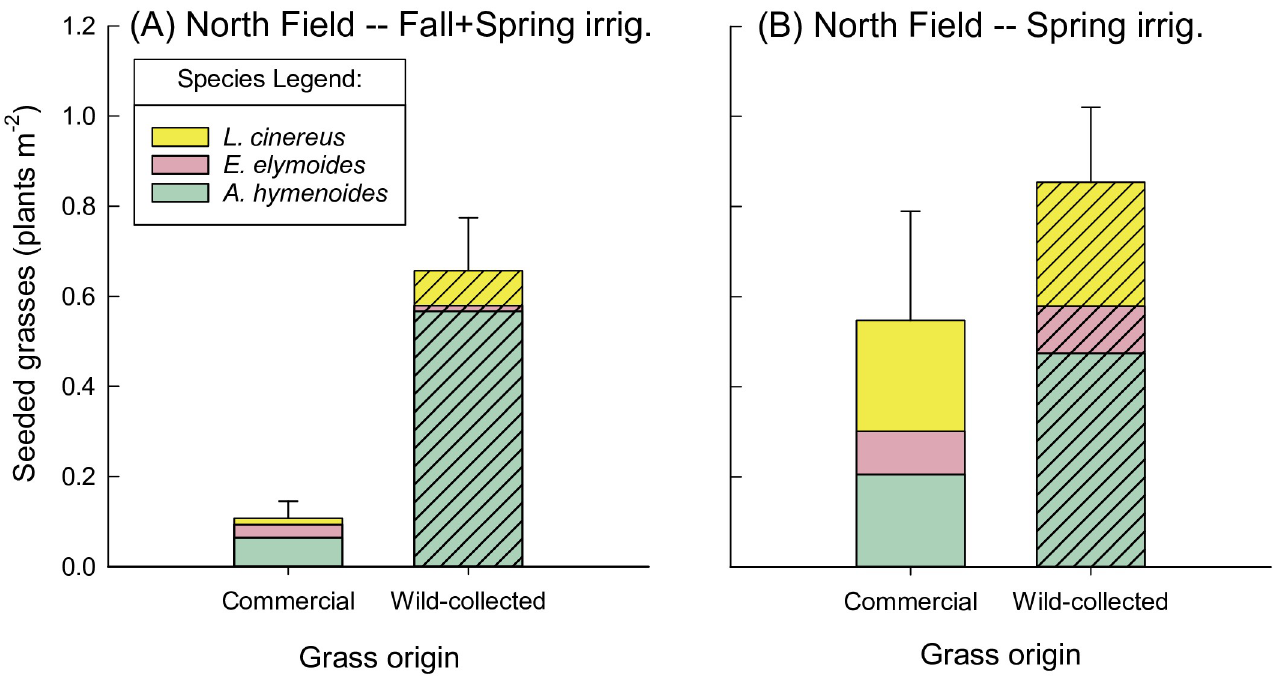
Fig 6. Seeded grasses in the North Field in May 2017, by irrigation treatment and grass origin. Seeded grasses (plants m -2 ) in May 2017, excluding Sporobolus airoides (which had only one origin), shown by grass origin for the (A) North Field, Fall+Spring irrigation, and (B) North Field, Spring irrigation. Grass seed origin is indicated by hash marks for wild-collected origin, or no pattern for commercial origin. Densities of S . airoides averaged 1.40 ± 0.98 and 0.66 ± 0.27 plants m -2 in the Fall+Spring and Spring irrigation treatments, respectively.